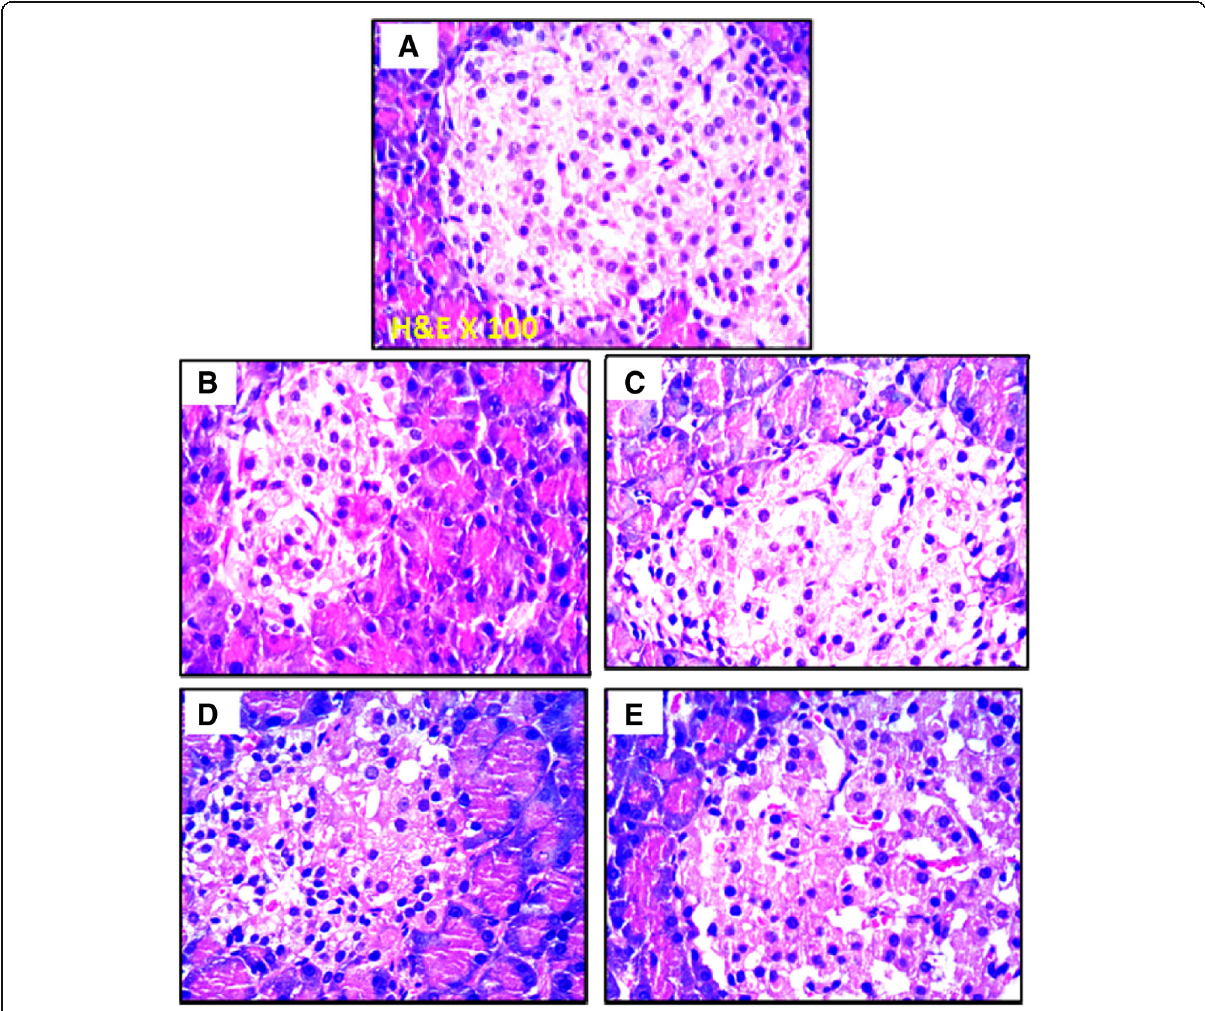
Fig. 3 TS the in pancreas showing histological changes in islets of Langerhans in different groups. a Normal control group. b Diabetic non- treated group. c Vildagliptin-treated group. d Bee venom high-dose (2 mg/kg)-treated group. e Bee venom low-dose (1 mg/kg)-treated group. Hematoxylin and Eosin (H&E) stain. Magnification power ×